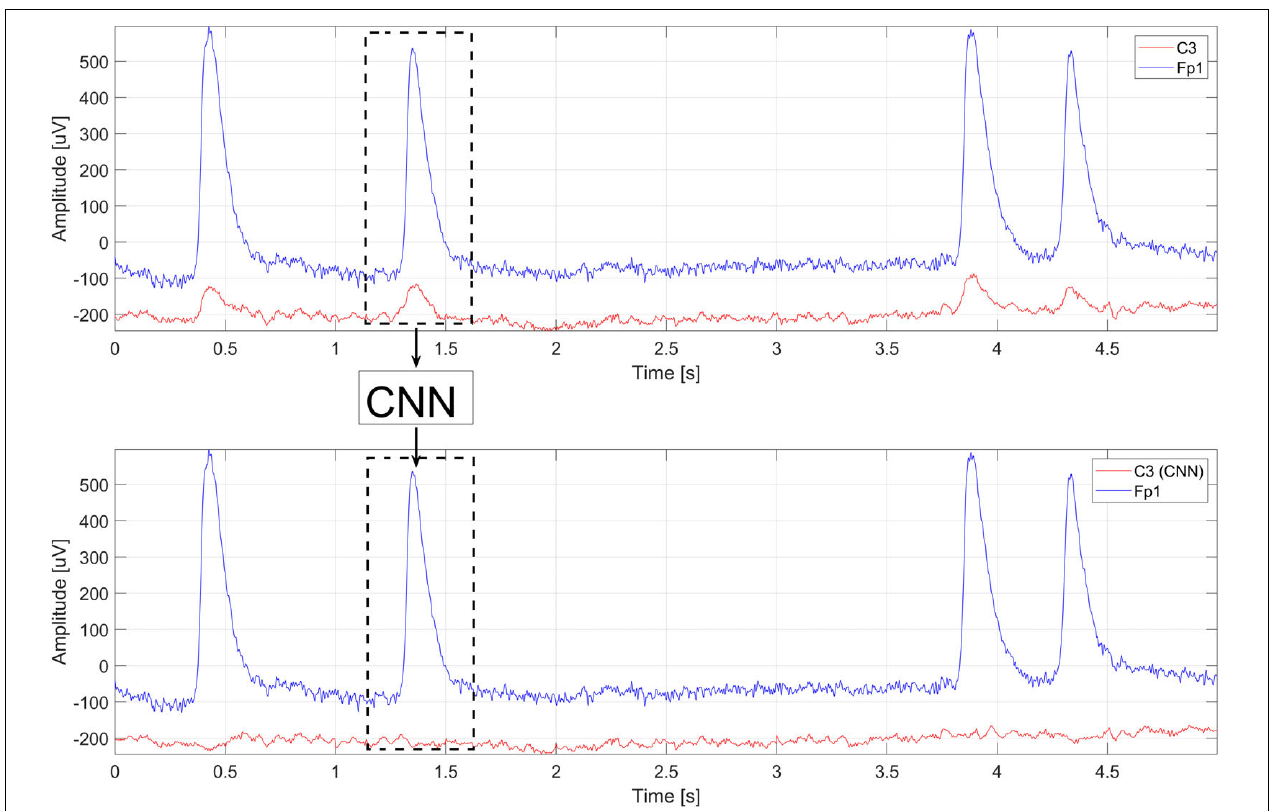
FIGURE 1 | The idea of using the CNN to eliminate artifacts.